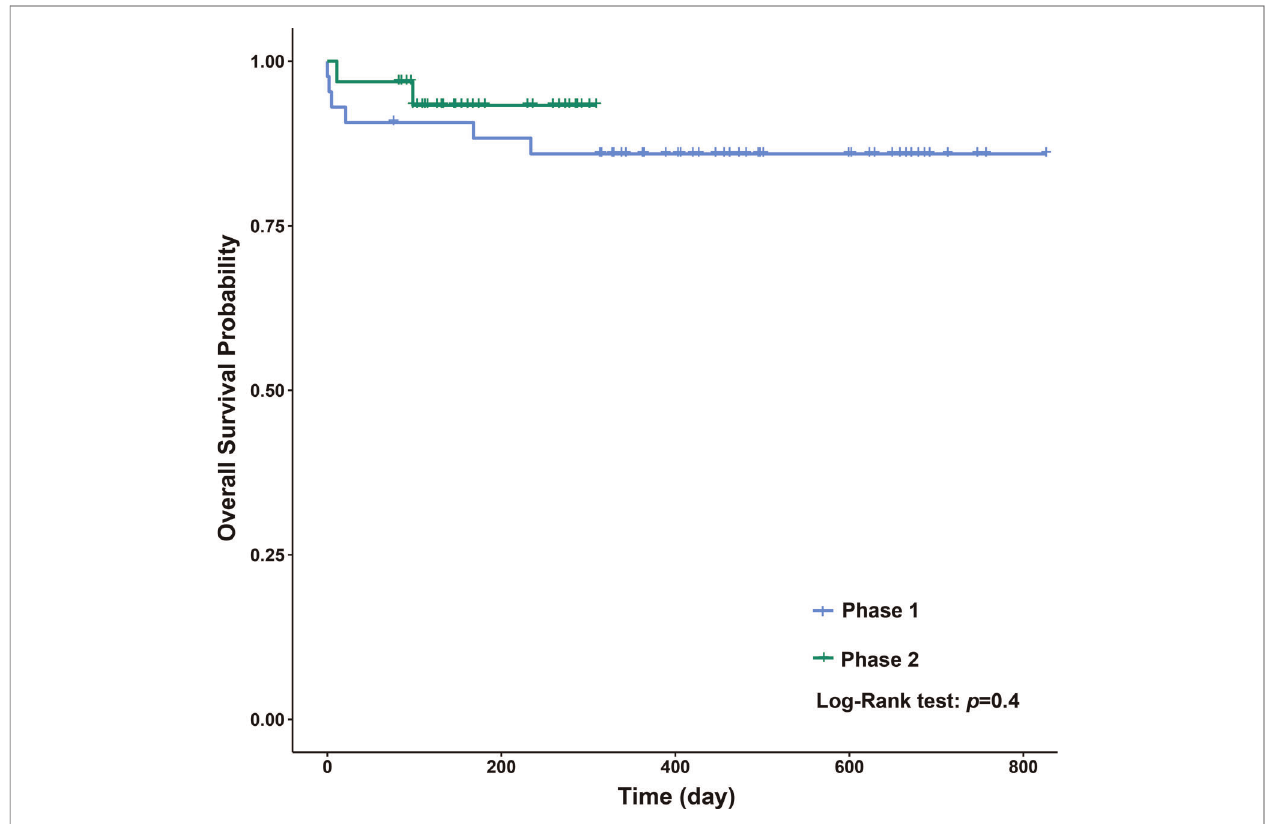
FIGURE 4 | Overall patients survival (Kaplan – Meier